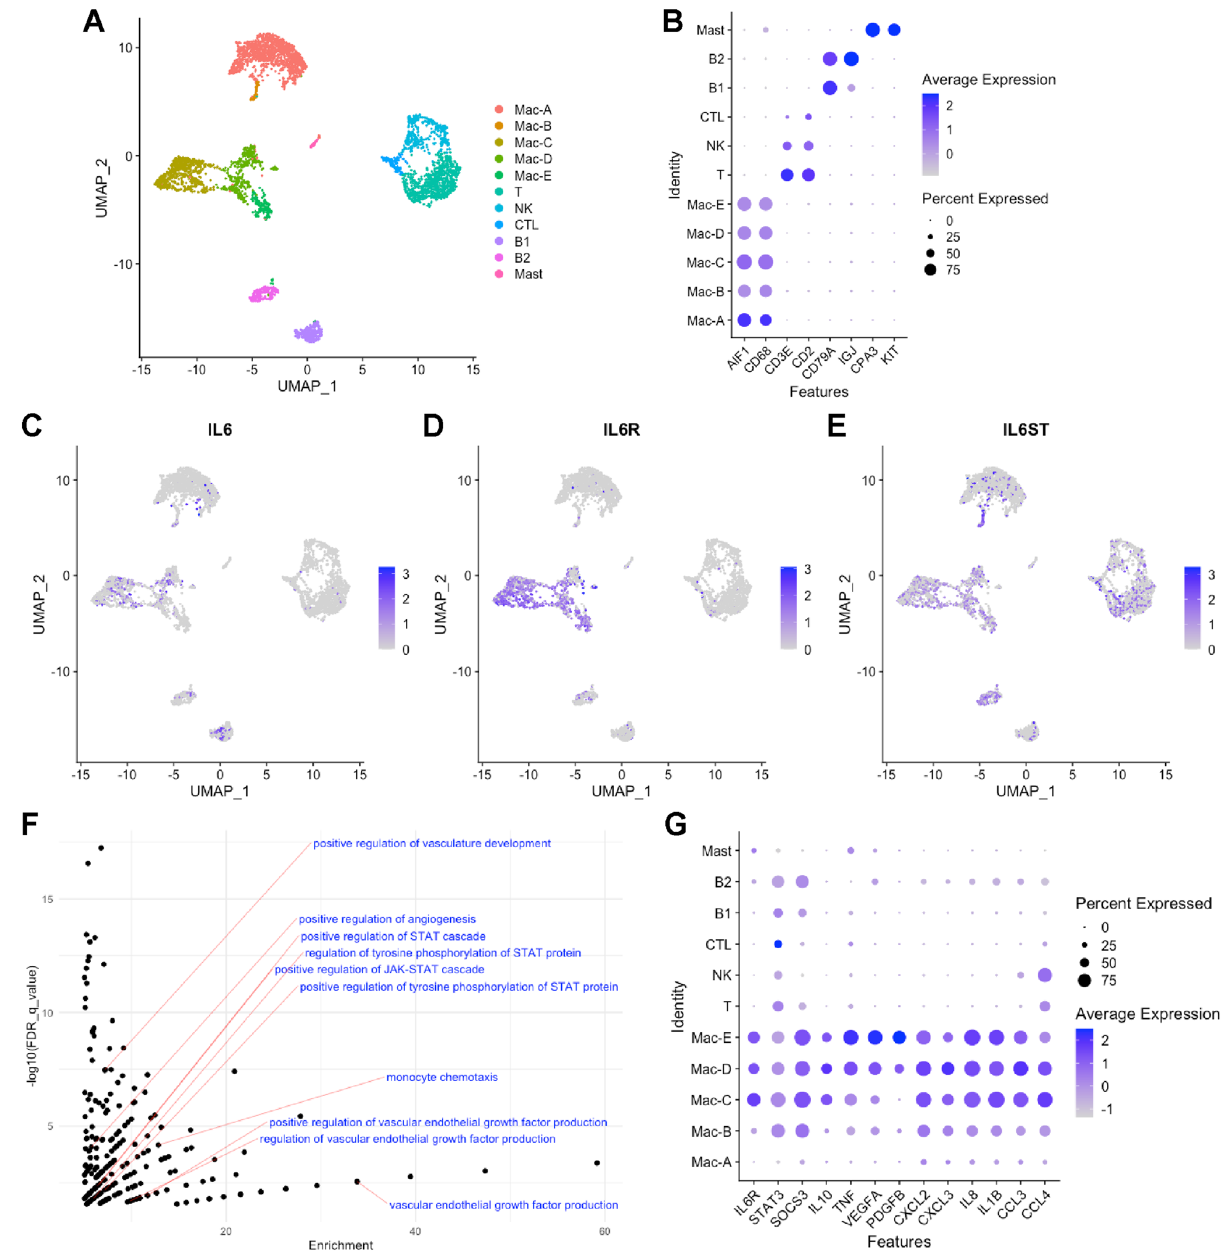
( F ) Scatter plot (q-value vs enrichment) of GO terms with labels. ( G ) Dot Plot of genes that drove GO term enrichment for STAT signaling, angiogenesis, and monocyte